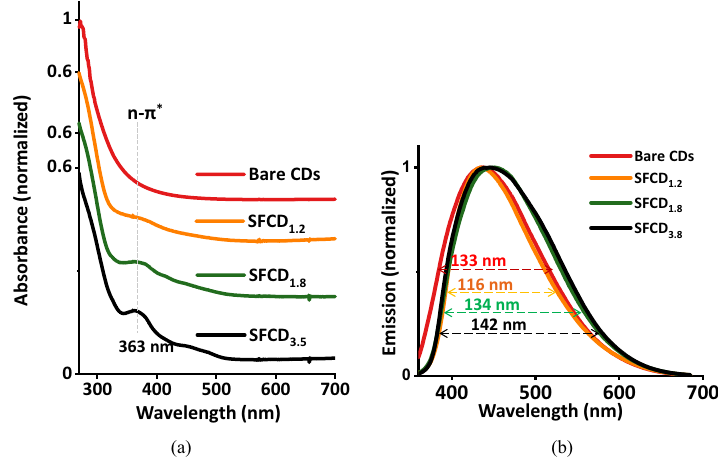
Figure 5. ( a ) Absorption and ( b ) emission spectra of colloidal CDs and SFCDs. Bare CDs show a broad absorption window ranging from 270 to 400 nm. This broad absorption spectra is a cumulative effect of electronic transitions between intrinsic carbon domains (π-π* electronic transitions) and between oxygenated surface groups on CD surface with intrinsic carbon domains (n-π* electronic transitions). SFCDs exhibit an absorption peak at 363 nm which intensifies and becomes prominent with increase in degree of surface functionalization from SFCD 1.2 to SFCD 3.5 . This peak corresponds to electronic transitions (n-π* electronic transitions) between surface groups (− NH 2 created by HDA) with intrinsic carbon domain. Further, bare CDs excited at 350 nm excitation wavelength, exhibit a broad emission spectrum ranging from 360 to 700 nm with a bandwidth of 133 nm which is highly expected for white light emitting sources. SFCD samples show bandwidth of 116 nm (SFCD 1.2 ), 134 nm (SFCD 1.8 ) and 143 nm (SFCD 3.5 ) with increase in degree of surface